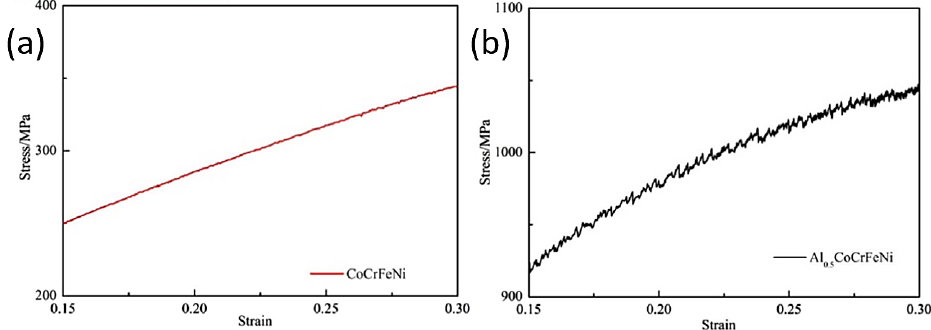
Figure 30. The engineering stress–strain curves for the ( a ) CoCrFeNi and ( b ) Al 0.5 CoCrFeNi HEAs during compression at a strain rate 10 −3 s −1 and temperature of 400 °C (reproduced from Reference [94] with permission).